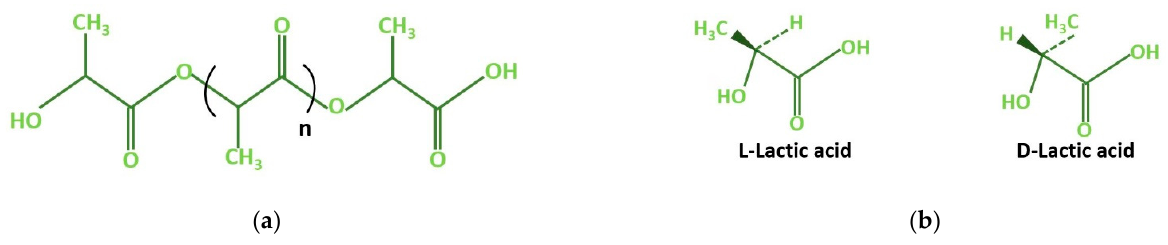
Figure 2. ( a ) Chemical structure of polylactic acid; ( b ) isomers of lactic